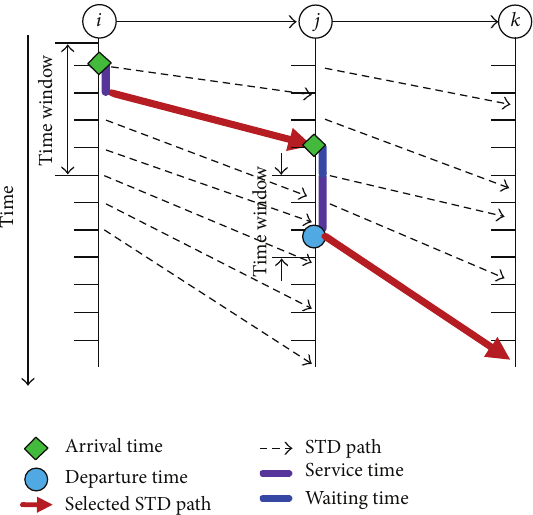
Figure 1: An Illustration of